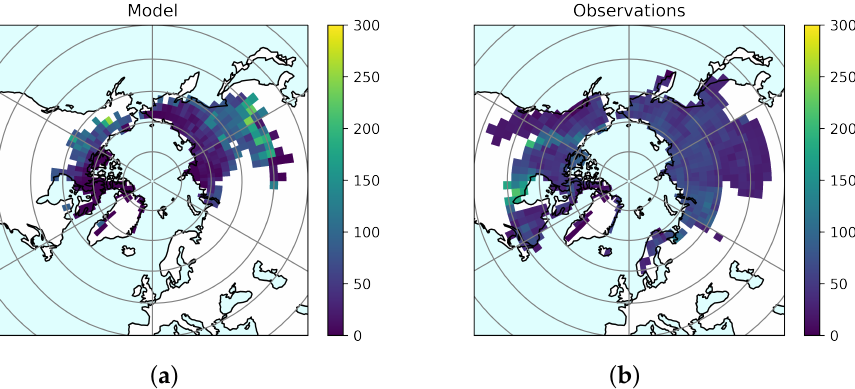
Figure 3. Distribution of the total soil carbon in top 3 m (kg m − 2 ) for CN spun ( a ). Shown in ( b ) is the total soil carbon for the top 3 m of the NCSCD observations